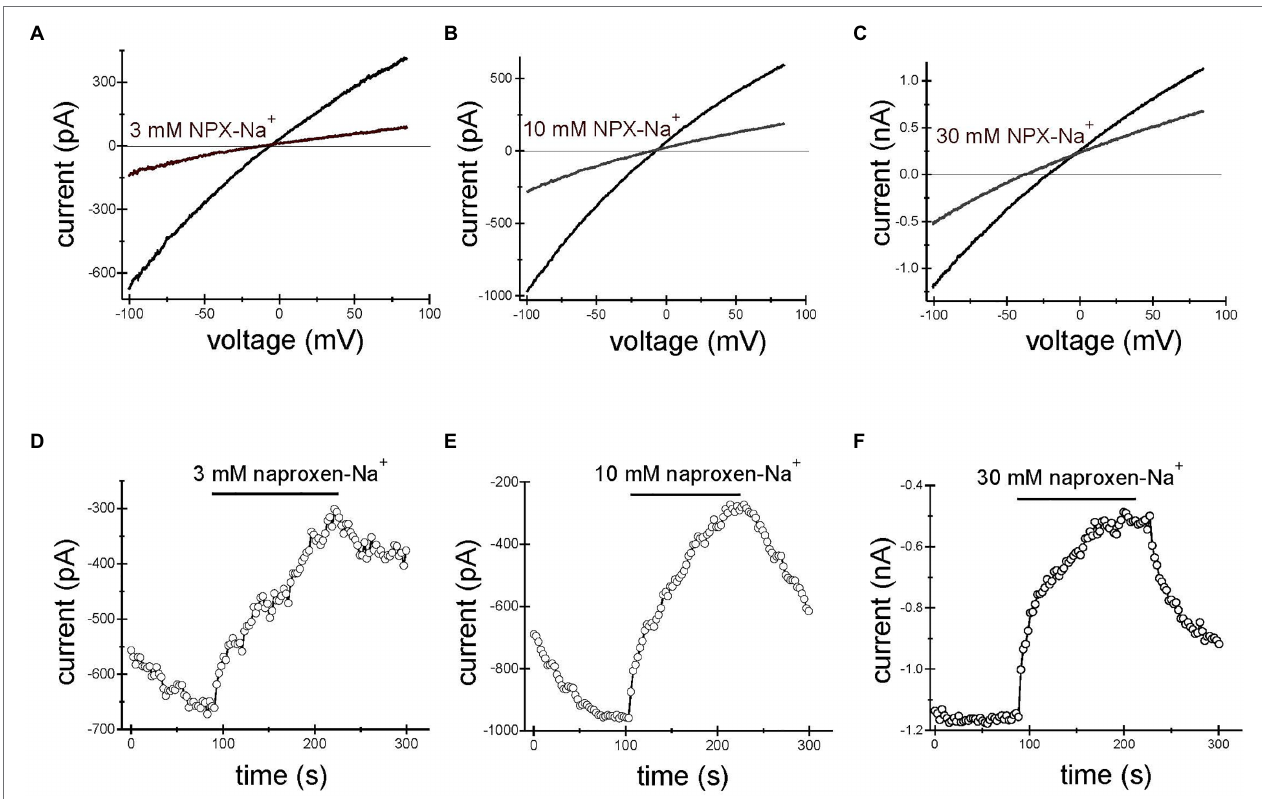
FIGURE 1 | Naproxen-Na + inhibits TRPM7 current. TRPM7 monovalent I–V relations in the absence and presence of 3 mM (A) , 10 mM (B) and 30 mM (C) naproxen. (D–F) Depict the time courses of inhibition by 3 mM (D) , 10 mM (E) , and 30 mM (F) naproxen. The presence of drug is indicated by horizontal bars. Inward current amplitude was measured at − 100 mV and plotted against time. Representative whole cell patch-clamp recordings from n = 10 (A,D) , n = 8 (B,E) , and n = 4 (C,F) Jurkat T cells. Here and in Figures 2, 3 , the drug was applied multiple times. The initial current development after break-in is not shown. The internal and external solutions were K + and Na + based,